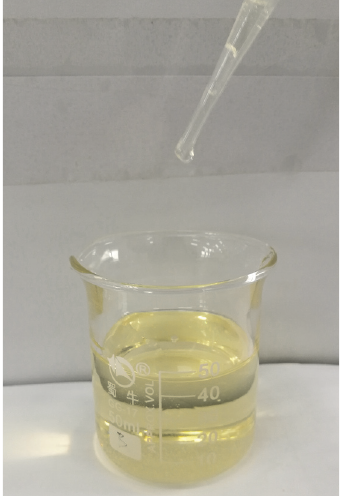
Figure 2: Photo of polyurethane soil stabilizer